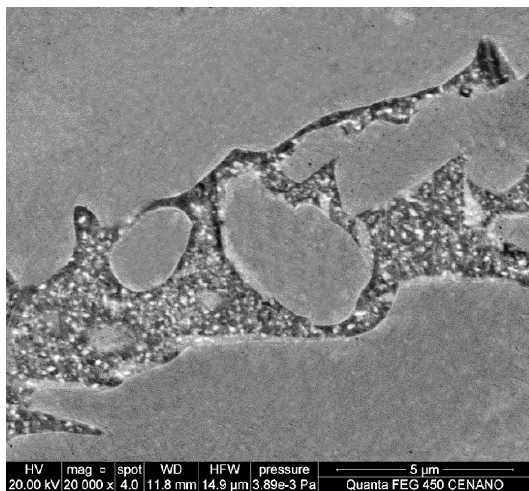
Figure 7. Base metal aged at 550 °C for 400 h.